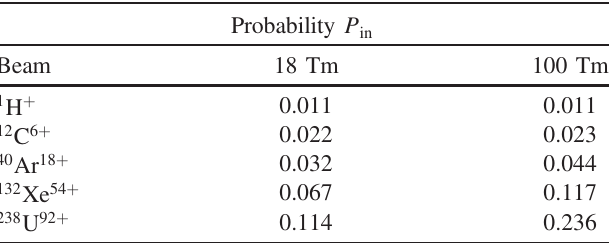
TABLE I. Probability P for the inelastic nuclear interaction of in the halo particles with 1 mm thick primary collimator made of tungsten calculated by using FLUKA . TABLE II. Deflection angle